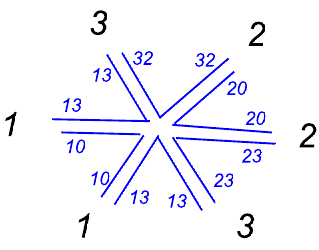
Figure 11 . A 6-valent vertex with index labels f 1 ; 1 ; 2 ; 2 ; 3 ; 3 g . When we resolve this into a